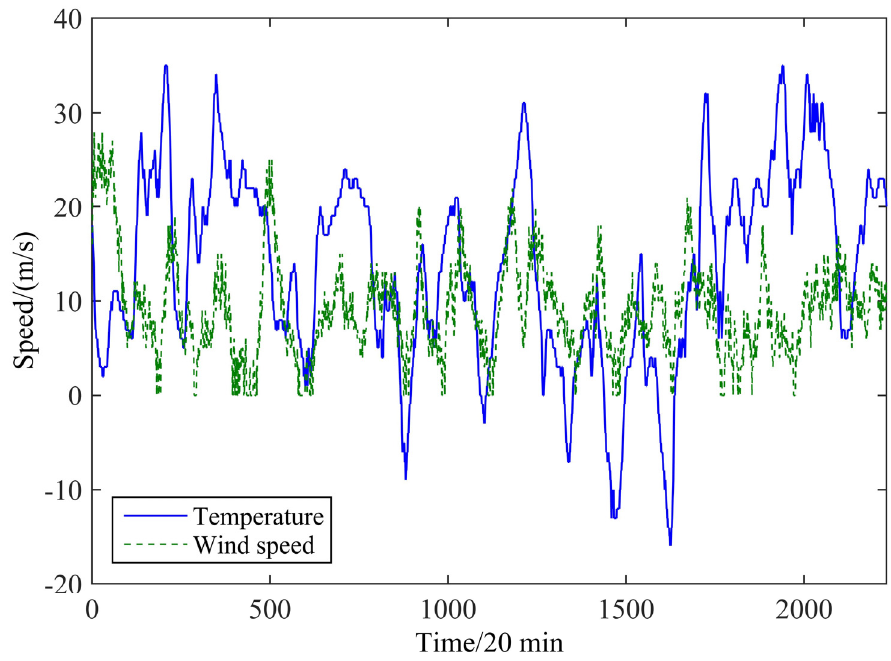
Figure 7. Relationship between the wind speed and temperature.